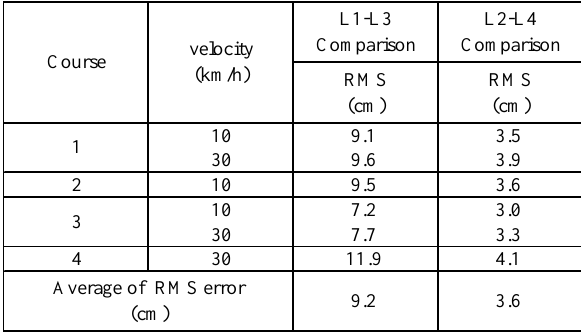
Table 2. Results of Precision Accuracy